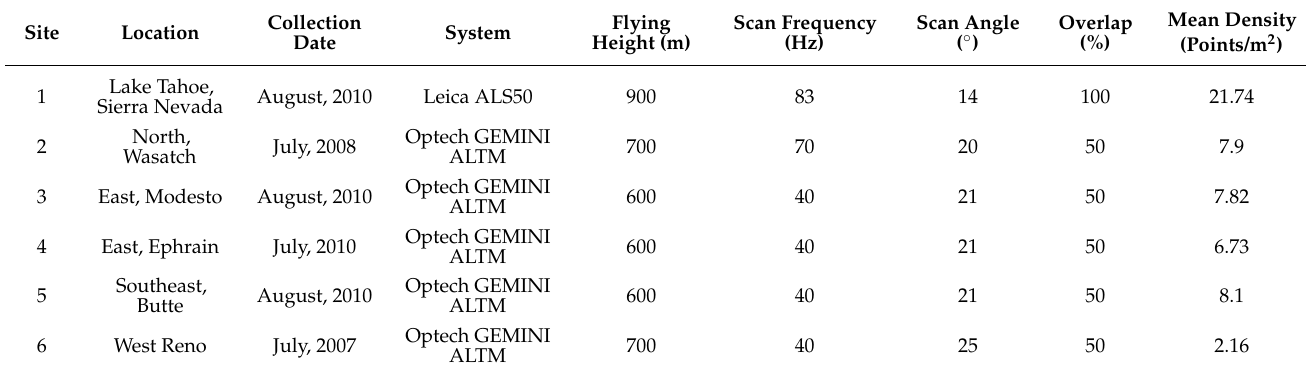
Table 1. LiDAR data collection information for the six forested